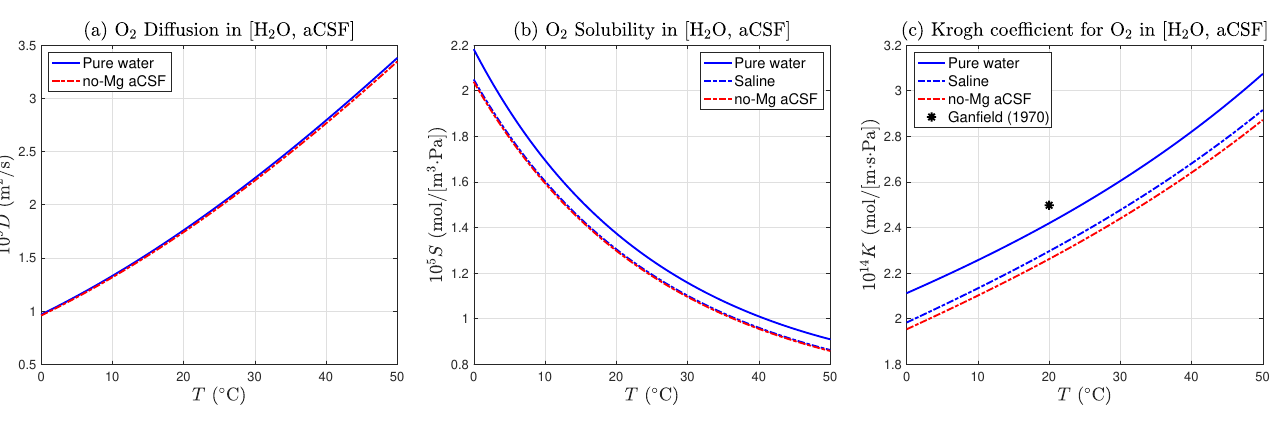
Figure 4. Temperature dependence of oxygen diffusion, solubility, and permeability in pure water, and in no-Mg artificial cerebral spinal fluid (aCSF). ( a ) Oxygen diffusion in aCSF (dashed-red trace) is depressed by ∼ 1% relative to pure water (solid blue trace) by small viscosity increase caused by presence of 0.02 mol/L glucose. ( b ) Oxygen solubility in aCSF is reduced by ∼ 5% by ‘salting out’ effect of chloride salts (dashed-blue trace) with chlorinity [ m Cl ] = 4.904 g/kg; and by a further ∼ 0.5% by glucose effect. ( c ) Oxygen Krogh coefficient in fluid is given by the product of diffusion and solubility, K = DS . Glucose effect is assumed to be cumulative, resulting in a ∼ 1.5% depression below the saline curve. Asterisk (*) marks the value ( K ∗ = 2.5 × 10 − 14 mol/(m · s · Pa)) used by Ganfield et. al. (1970) [8] for Krogh coefficient for fluid at 20 ◦